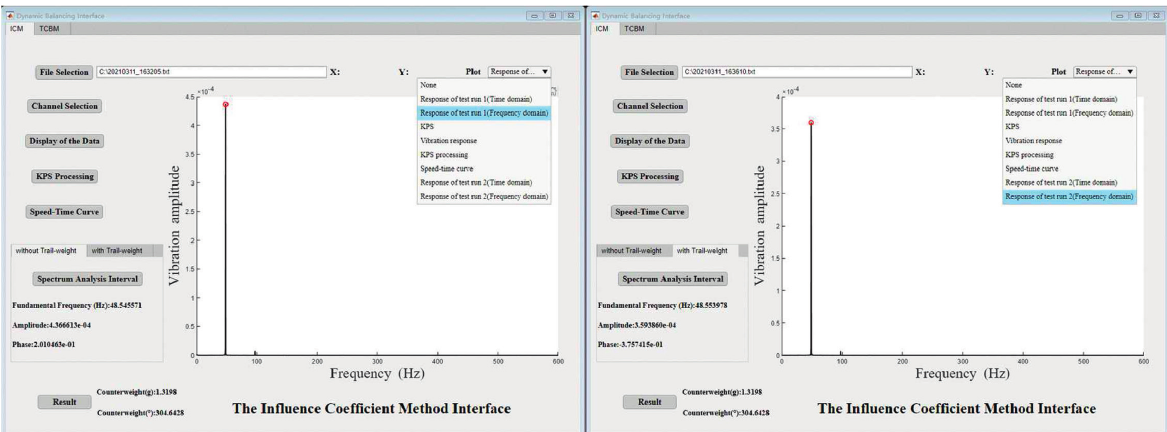
Figure 16: The counterweight identified by the ICM interface.